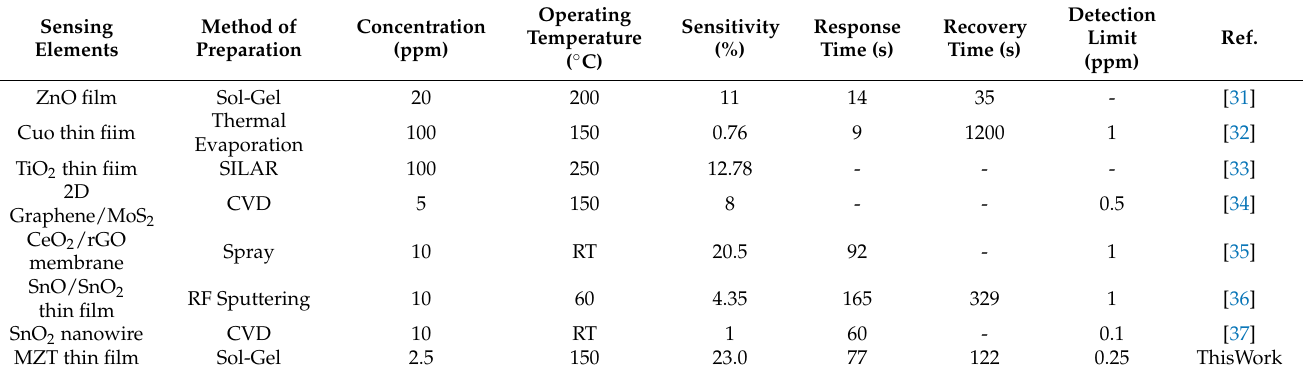
Table 1. Comparison of the MZT thin film gas sensor with other published NO 2 gas sensors. Sensing